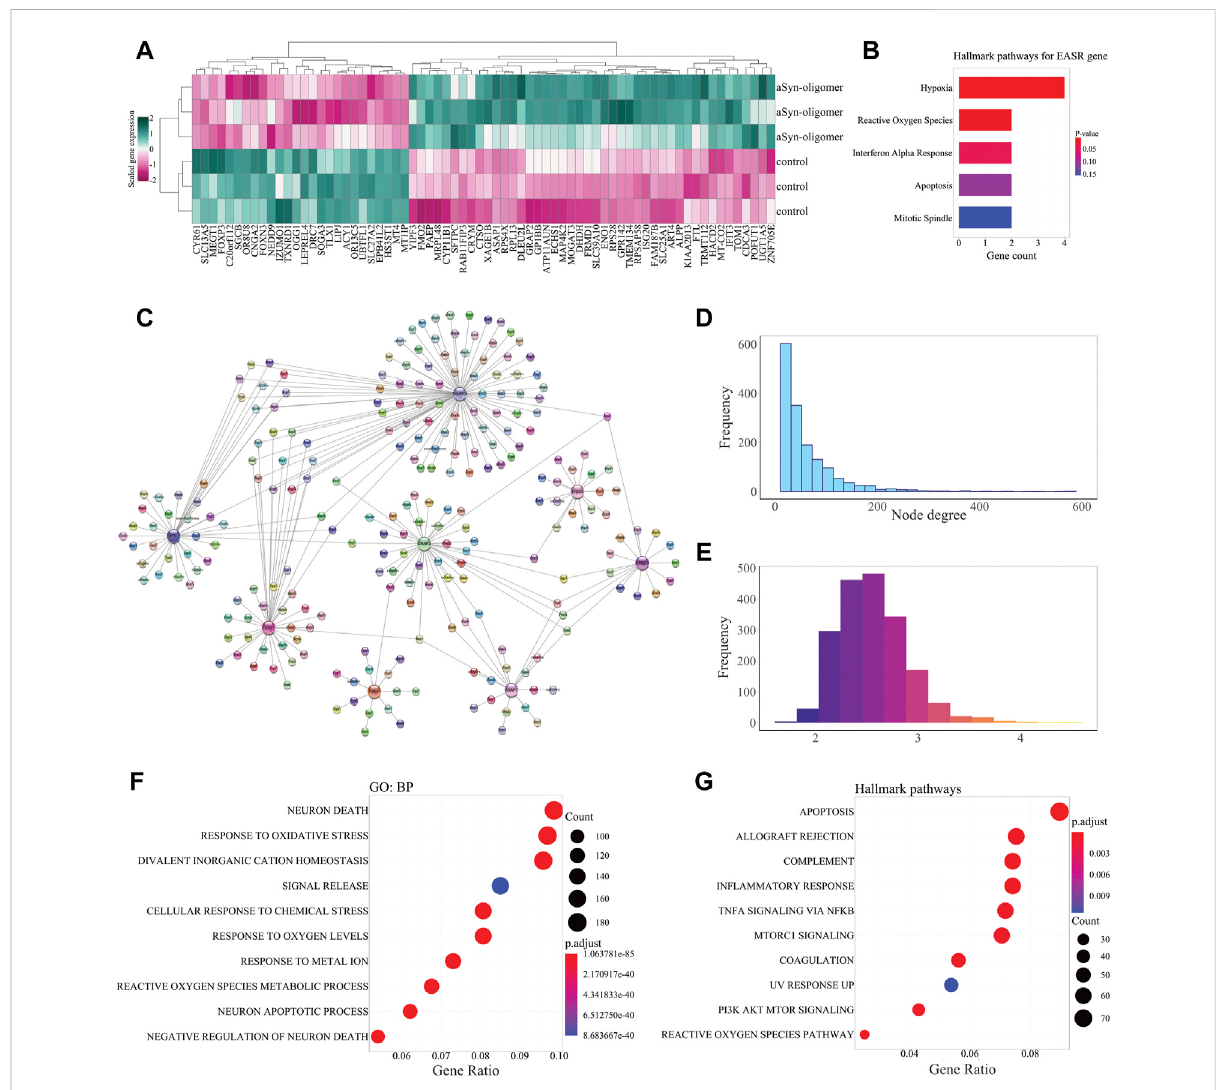
FIGURE 2 EASR genes and their functional relation to PD-related genes. (A) Heatmap of the scaled expression level of differentially expressed genes ( p -value < 0.05, and fold change > 1.5) in response to exogenous α SN oligomers. Heatmap displays 44 upregulated and 26 down-regulated genes that are considered EASR genes. (B) Hallmark pathway enrichment analysis represents EASR genes are signi fi cantly enriched only for hypoxia, reactive oxygen species pathway, and interferon-alpha response. (C) The PD-EASR subnetwork of 8 overlapped genes (between PD-related and EASR genes) and their connections. The PD-EASR network was constructed and visualized by StringApp in the Cytoscape software, which represents protein-protein interactions between PD-related and EASR genes. (D) The Degree distribution shows that most nodes have only small degrees, while a few nodes have vast degrees. This property indicates that the PD-EASR network is a scale-free network. (E) Average shortest path length frequency. The PD-EASR network ’ s average shortest path length-frequency shows that 91.8% of the nodes were communicated together